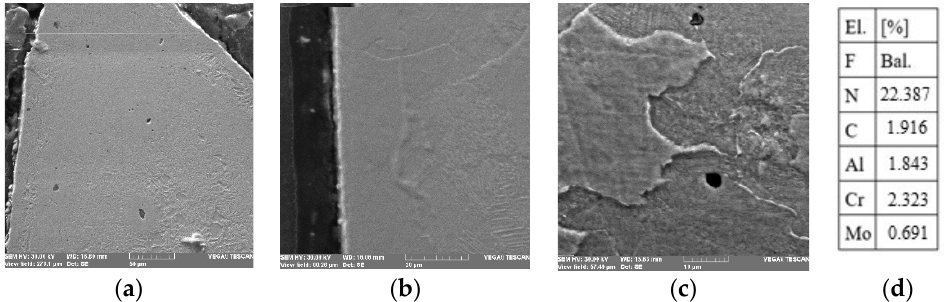
Figure 7. No screen nitrided sample SEM micrographs, 30° area C, different scale: ( a ) 50 µm, ( b ) 20 µm, ( c ) 10 µm, and ( d ) mass concentration of elements per area.